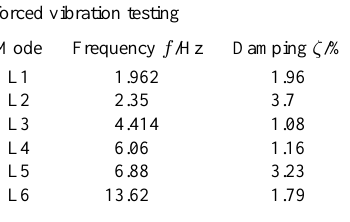
Table 1 Lateral modes estimated from ambient and